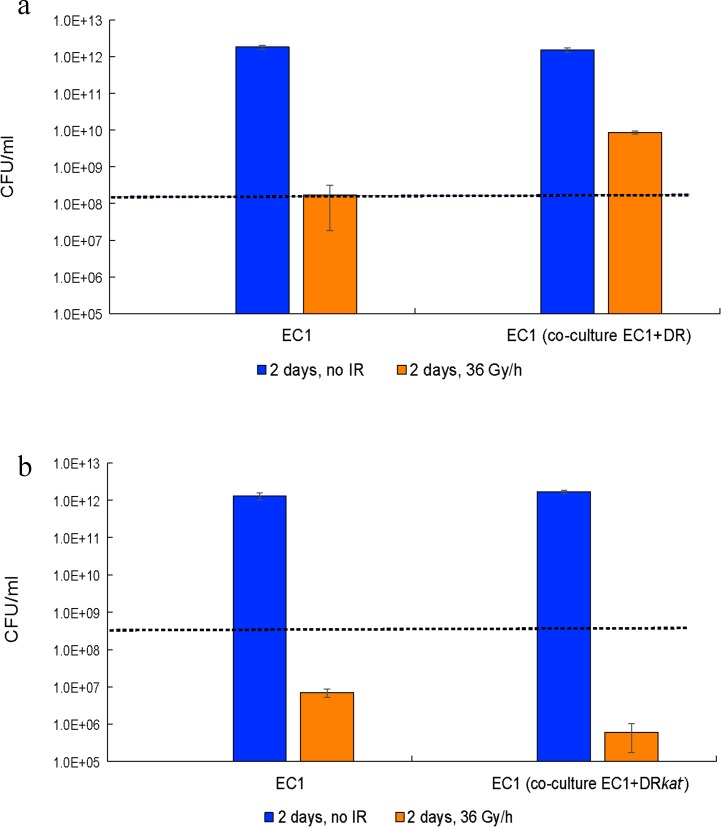
Microbial cooperation under CIR.a: Growth of EC1 in the presence or absence of 36 Gy/h for 2 days, either in pure culture or mixed in 1:1 co-culture with DR. b: As for panel A, but with DRkat- substituting for DR. The y-axis shows clonogenically viable cell concentrations normalized to 1 ml: the actual numbers of viable cells are 200 times smaller because only 5 μl of each species were used in these experiments. Dashed lines indicate cell concentrations under the assumption of no net proliferation.